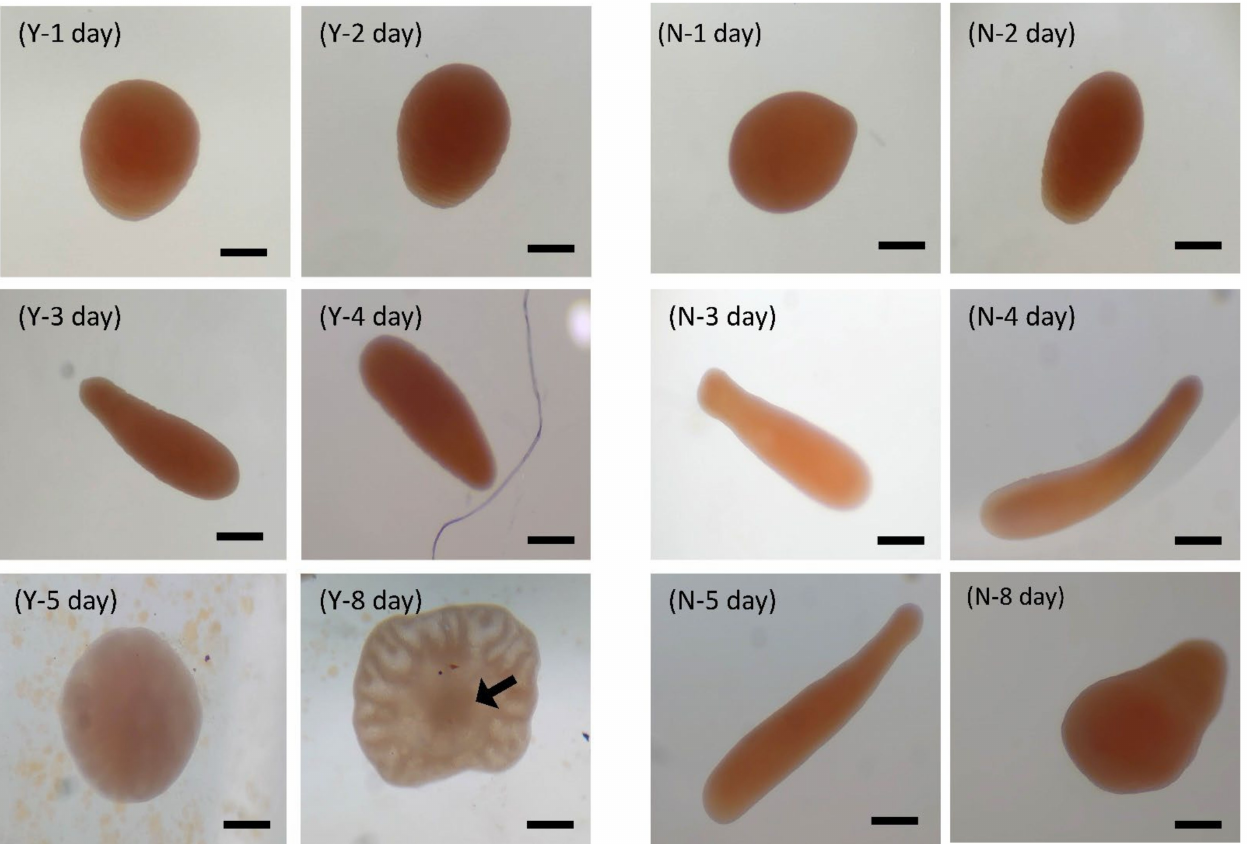
Figure 7. The effect of feeding on Briareum violacea larval development during temperature and salinity stress (scale bar: 100 µ m). 1 day: the eggs are round and sticky and adhere to the surface of the aquarium tank. Two days: the planula larva, which is in the shape of a drop, begins to crawl slowly. Three days: the body of the planula larva is elongated; the tip is the head and it crawls and moves quickly. Four days: in the Y group, the planula larva has a body length of about 730 µ m and a relatively slender body. In the N group, the planula larva has a body length of about 500 µ m and a round head. Five days: in the Y group, the planula larva has begun to prepare settlement. In the N group, the planula larva slows down and its body length is about 800 µ m. Eight days: in the Y group, the settlement is complete, and the larva is attached to the aquarium tank. The arrow points to the undifferentiated polyps. In the N group, there is slower development and no settlement yet. Y: feeding treatment group, N: nonfeeding